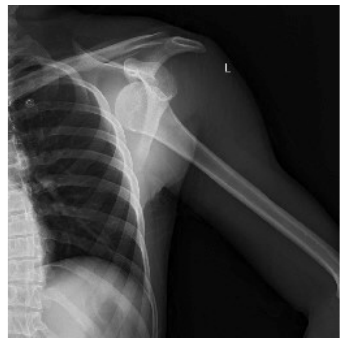
Figure 1. Anterior dislocation of the right